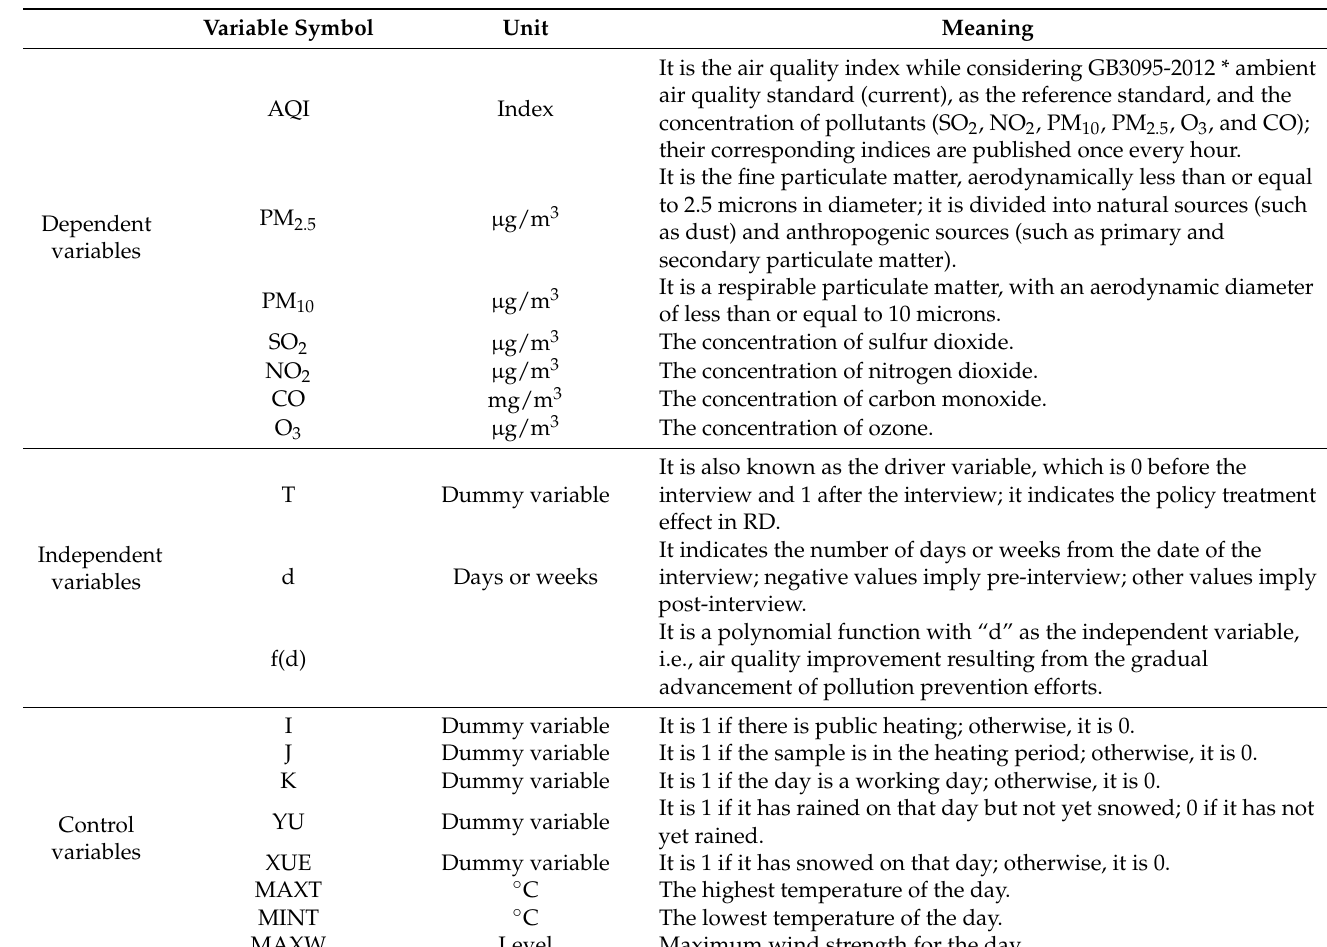
Table 1. Symbols and meanings of various